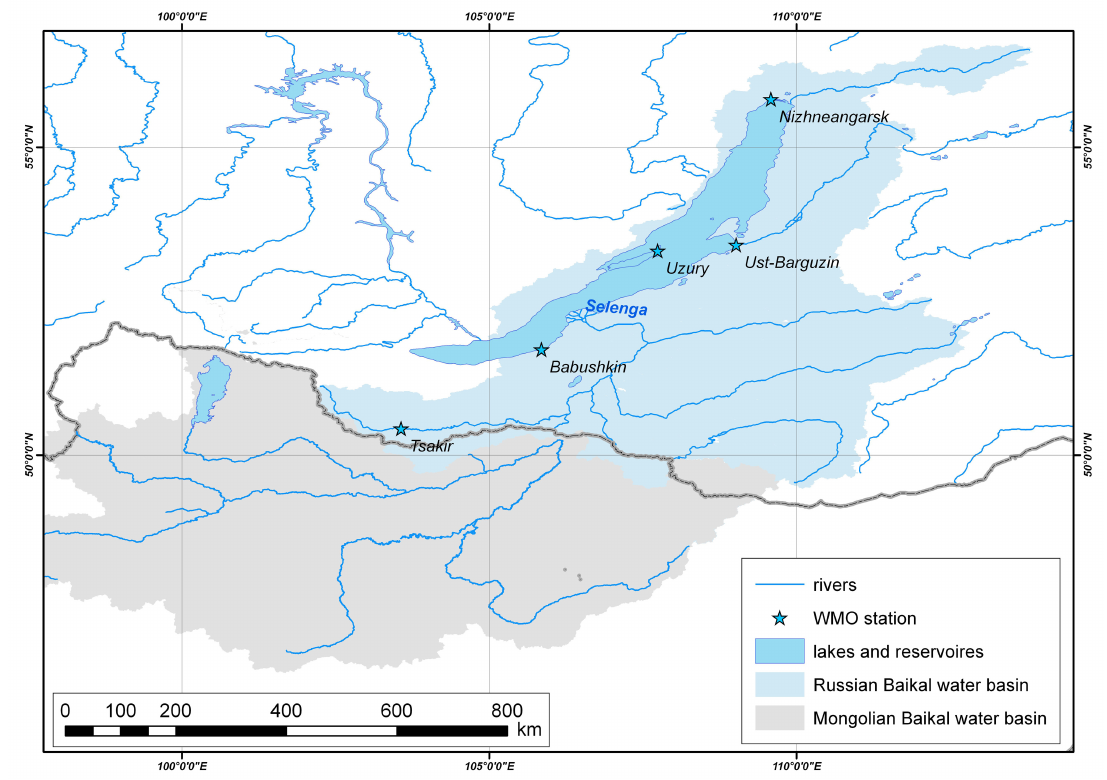
Figure 1. Overview of the Lake Baikal basin region; Russian and Mongolian parts are marked as blue and gray areas, respectively. The country boundary is shown as a bold gray